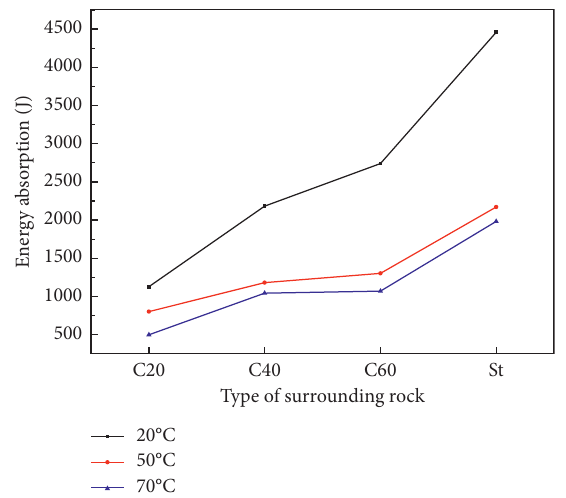
Figure 12: Energy absorption under different temperatures and country rock strength